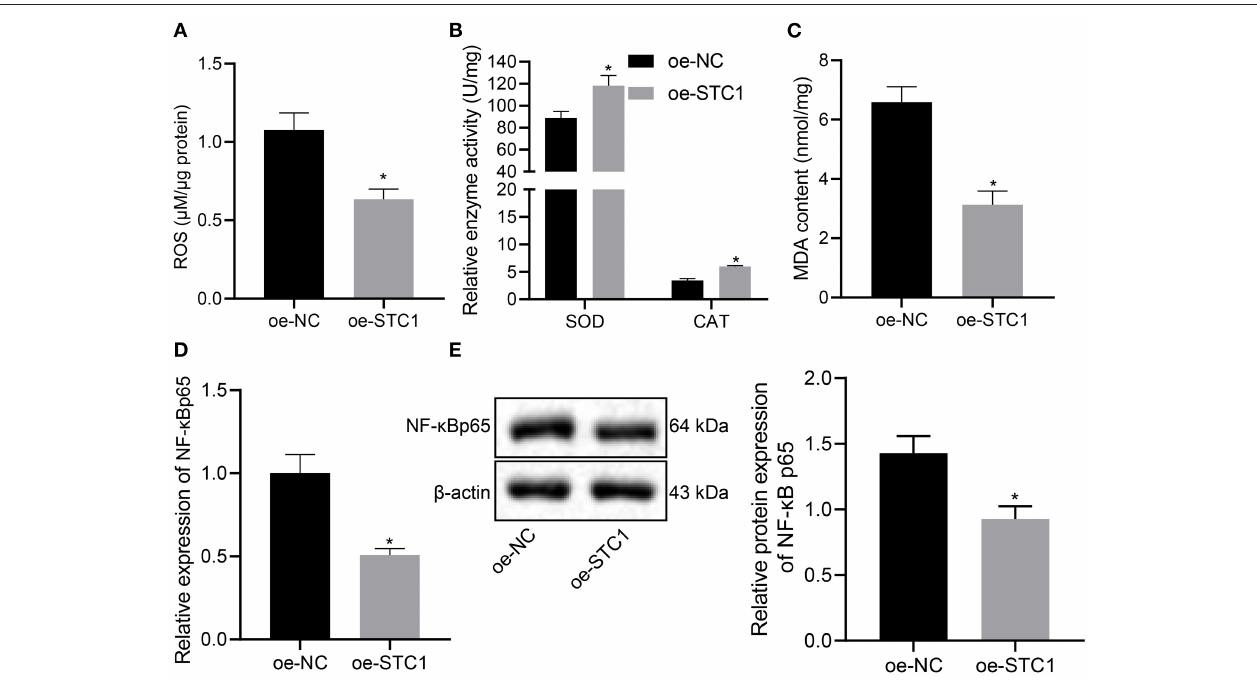
FIGURE 4 | STC1 overexpression inhibits the ROS/NF- κ B signaling pathway. (A) ROS production in hippocampal neurons induced by CORT. (B) SOD and CAT activity in hippocampal neurons induced by CORT. (C) MDA level in hippocampal neurons induced by CORT. (D) NF- κ B p65 mRNA expression in hippocampal neurons induced by CORT determined by RT-qPCR. (E) NF- κ B p65 protein expression in hippocampal neurons induced by CORT measured by Western blot assay. * p < 0.05 vs. neurons treated with oe-NC. Cell experiment was repeated 3 times.